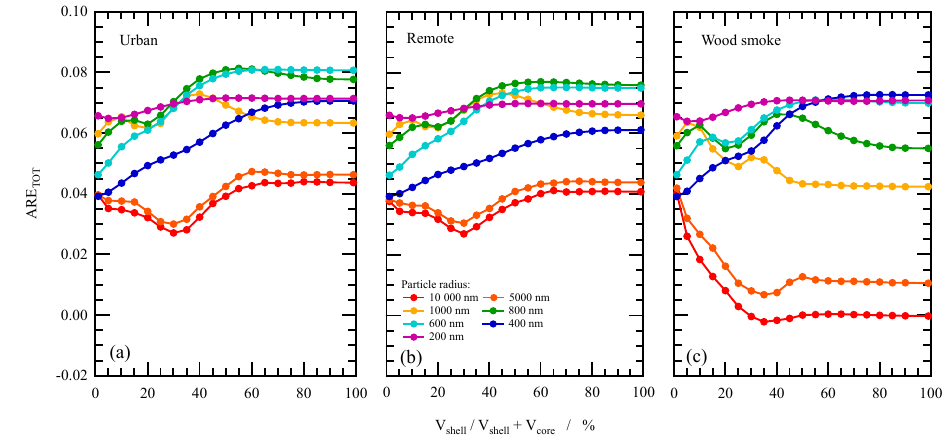
Figure 6. The aerosol radiative effect for the change in top-of-the-atmosphere albedo upon core-shell morphology formation in atmospheric aerosols. The shell material consists of the urban atmospheric aerosol extract (a) , remote atmospheric aerosol extract (b) , or woodsmoke atmospheric aerosol extract (c) , whilst the core for all calculations was water. The radius of the core was varied seven times. The left-hand side of the graph corresponds to pure aqueous droplets, and the right-hand side to pure organic